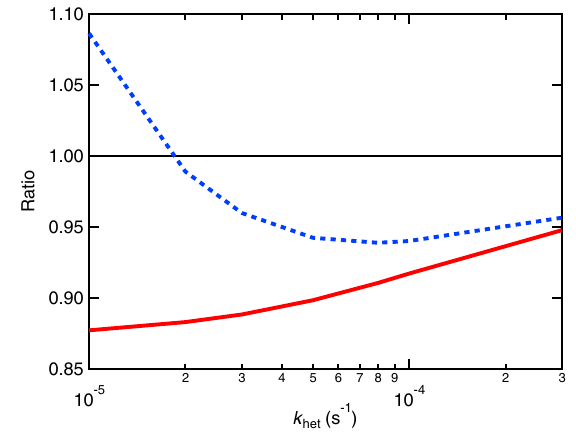
Figure C1. Model results showing the influence of including NO 3 + VOC reactions on HNO 3 production via the heterogeneous hydrol- ysis of N 2 O 5 , as a function of the heterogeneous oxidation rate. The red line shows the ratio between the HNO 3 produced via N 2 O 5 hy- drolysis when reactions with VOCs are considered and when they are not. Reaction of NO 3 with VOCs reduces the HNO 3 formed via hydrolysis. The blue line shows the ratio between the total HNO 3 produced from either N 2 O 5 hydrolysis or NO 3 + VOC reactions when reactions with VOCs are considered and when they are